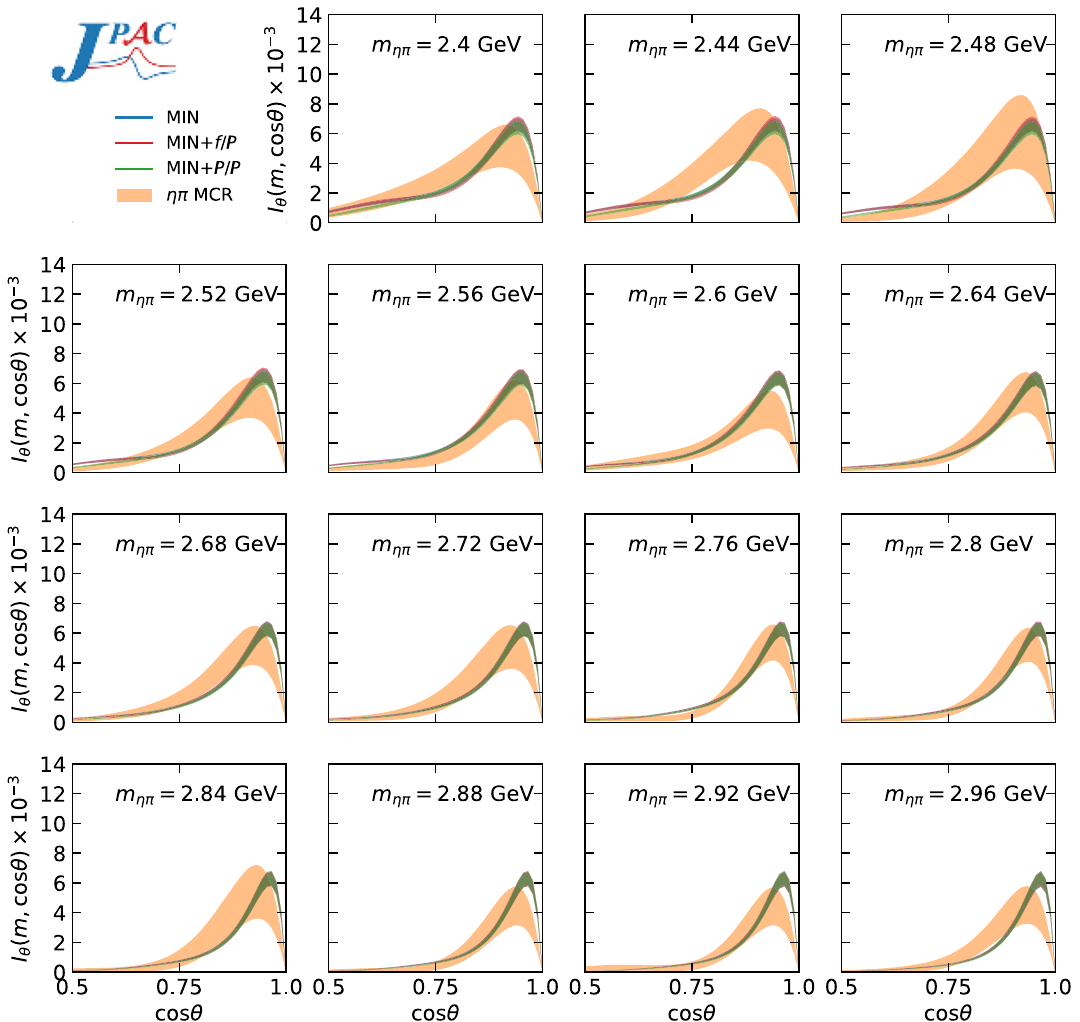
Fig. 12 Experimental I θ ( m ηπ , cos θ) from MCR (orange) for the forward region compared to the MIN (blue), MIN + f / IP (red) and MIN + IP / IP (green) fits. Bands correspond to the 68% confidence level. The three model curves mostly